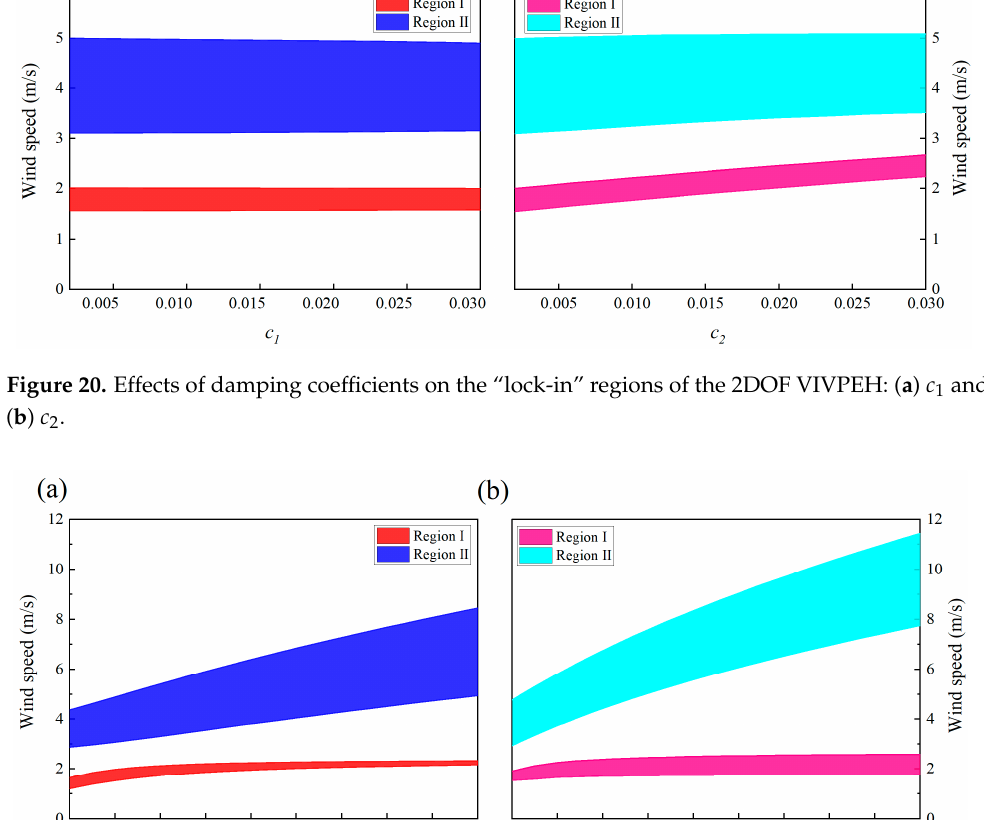
Figure 21. Effects of stiffnesses on the “lock-in” regions of the 2DOF VIVPEH: ( a ) k 1 and ( b ) k 2 .